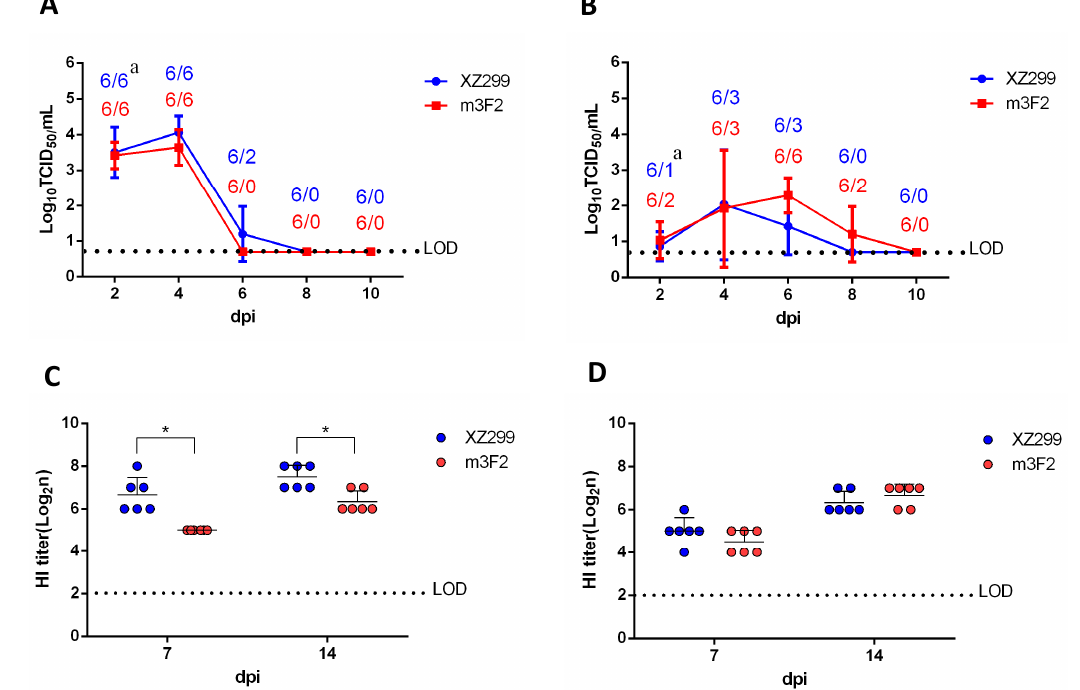
Figure 4. Infection study in chicken. Two-week-old chickens were inoculated with 10 5 TCID 50 of XZ299 and m3F2. At 2, 4, 6, 8, and 10 dpi, the swab samples of the larynx ( A ) and cloaca ( B ) were collected from six chickens in each group and titrated for the virus shedding by TCID 50 in MDCK cells. At 7 and 14 dpi, six chickens from each group ( C , D ) were bled to analyze HI titers against XZ299 and m3F2. a The number of the total sample/the number of the virus positive sample. * p < 0.05.